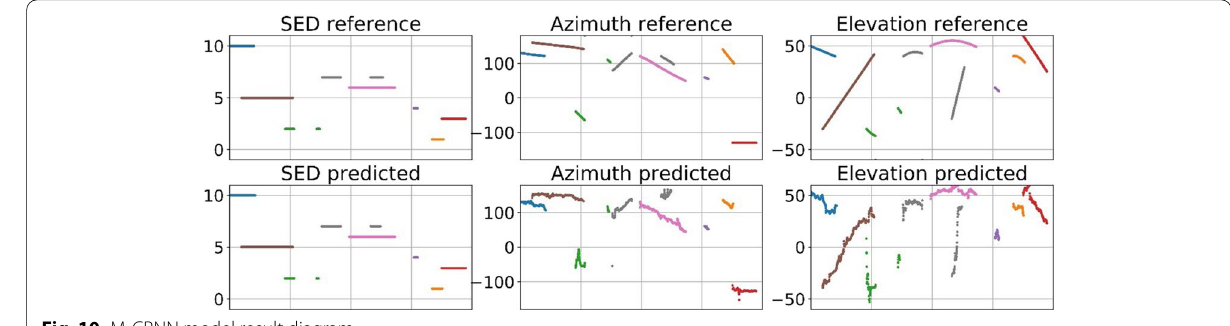
Fig. 10 M-CRNN model result diagram